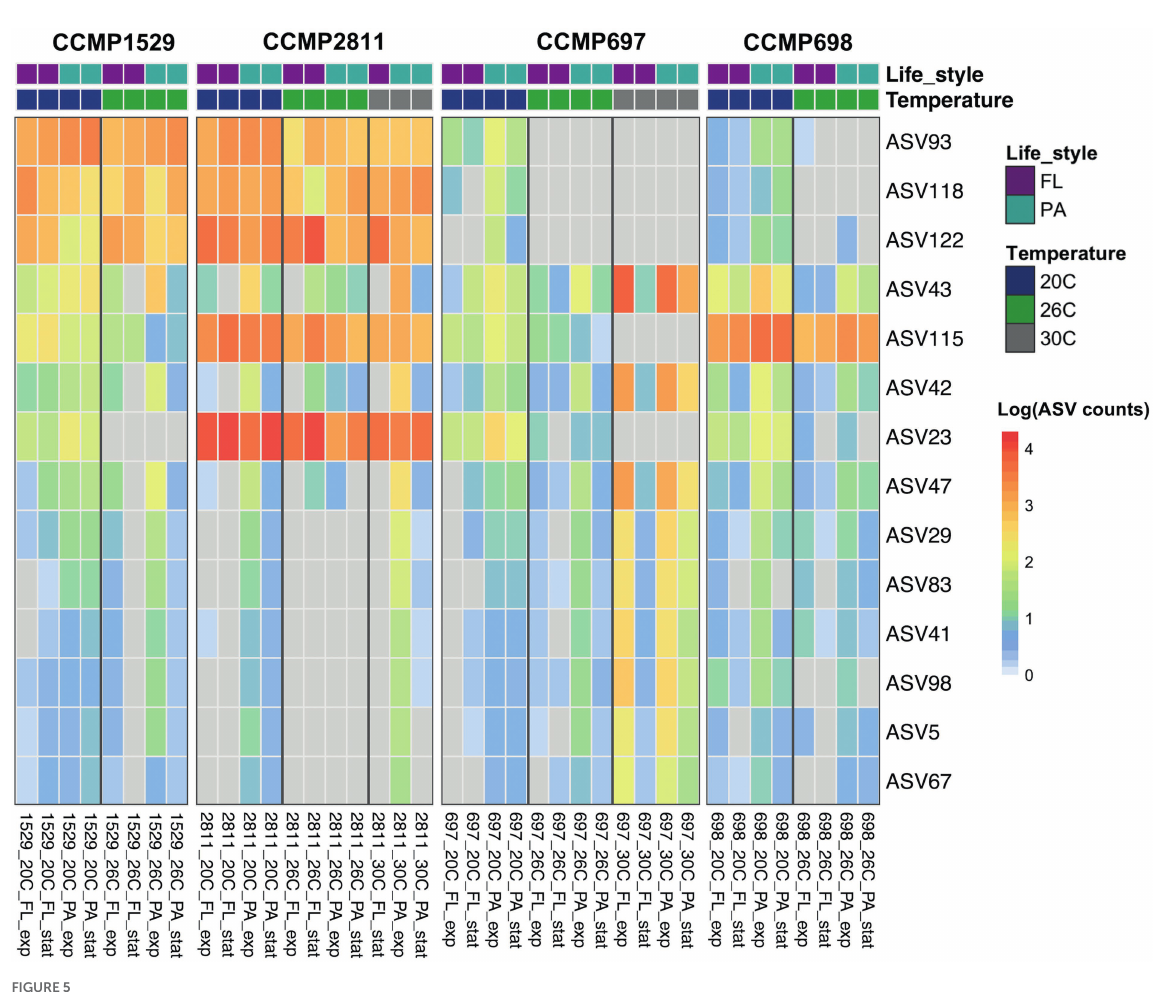
FIGURE 5 Core microbiome of Prorocentrum cordatum . Heatmap showing the abundance of the ASVs detected in all four xenic strains of P. cordatum at different conditions and temperatures. See Figure 4 for details of calculations. ASV rows are sorted by